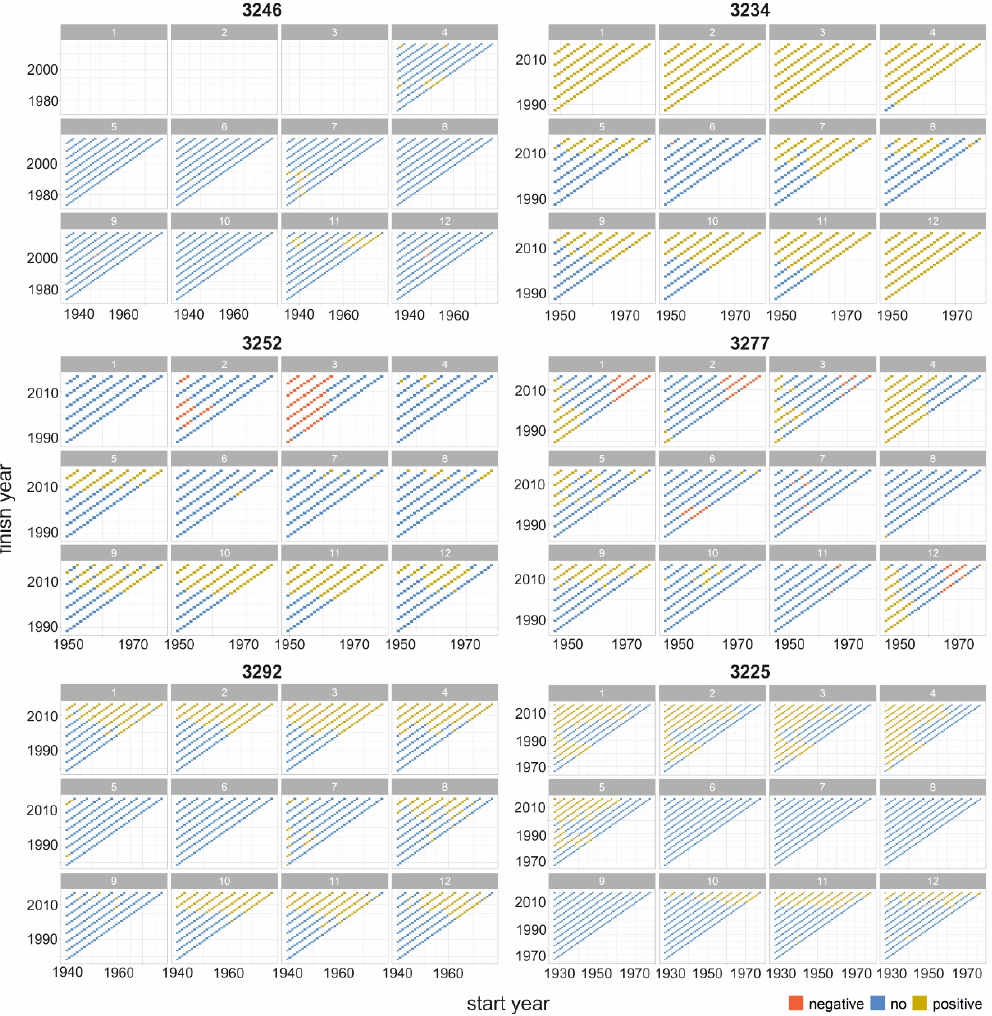
Figure 7. Trend patterns for different months, start and finish years for Timpton at Nagorny (3246), Ulakhan-Nymnyr at Bolshoy Nimnyr (3234), Chulman at Chulman (3252), Allakh-Yun’ River at Allakh (3277), Amga at Amga (3292) and Aldan at Okhotsky Perevoz (3225).